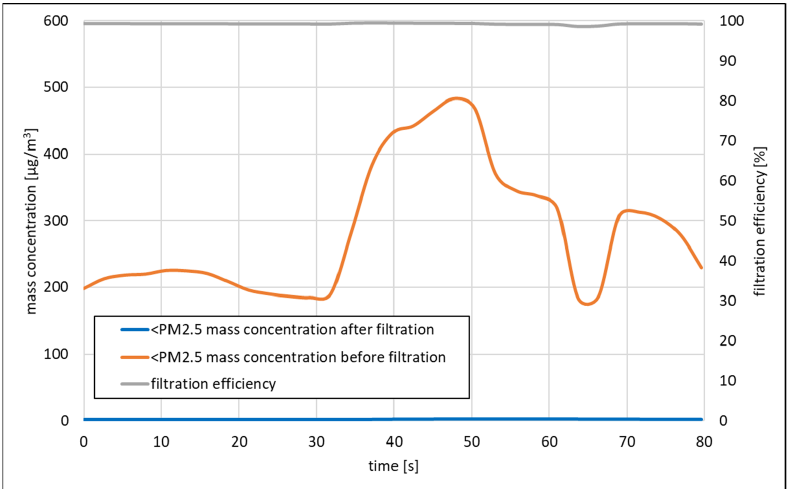
Figure 10. Mass concentrations of dust before and after application of activated carbon layer + F5 filter + EPA11 filter (temperature: 14 ◦ C, relative humidity: Table 1. Characteristics of examined three ‐ stage filter.